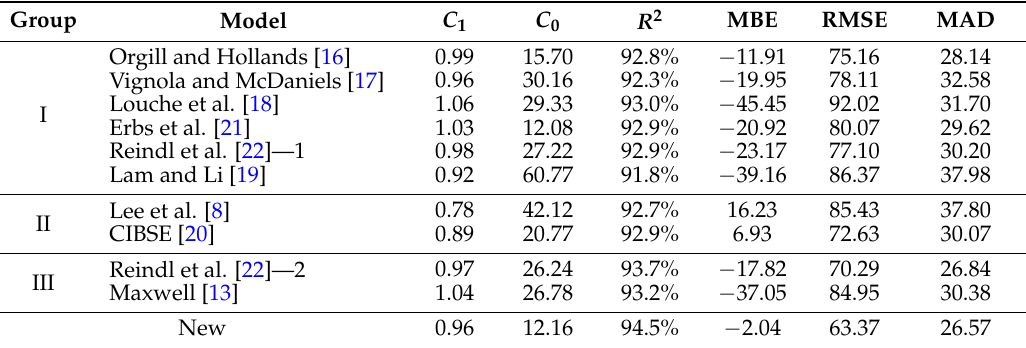
Table 1. Regression analysis of each model with a linear polynomial of y = C 1 x + C 0 : the coefficient of determination ( R 2 ), the mean bias error (MBE) as the measurement minus estimation, the root mean square error (RMSE), and the median absolute deviation